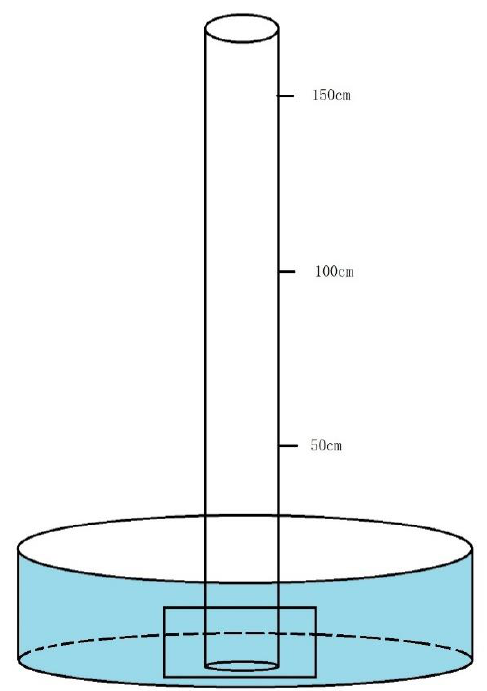
Figure 3. Capillary rising height measuring device.